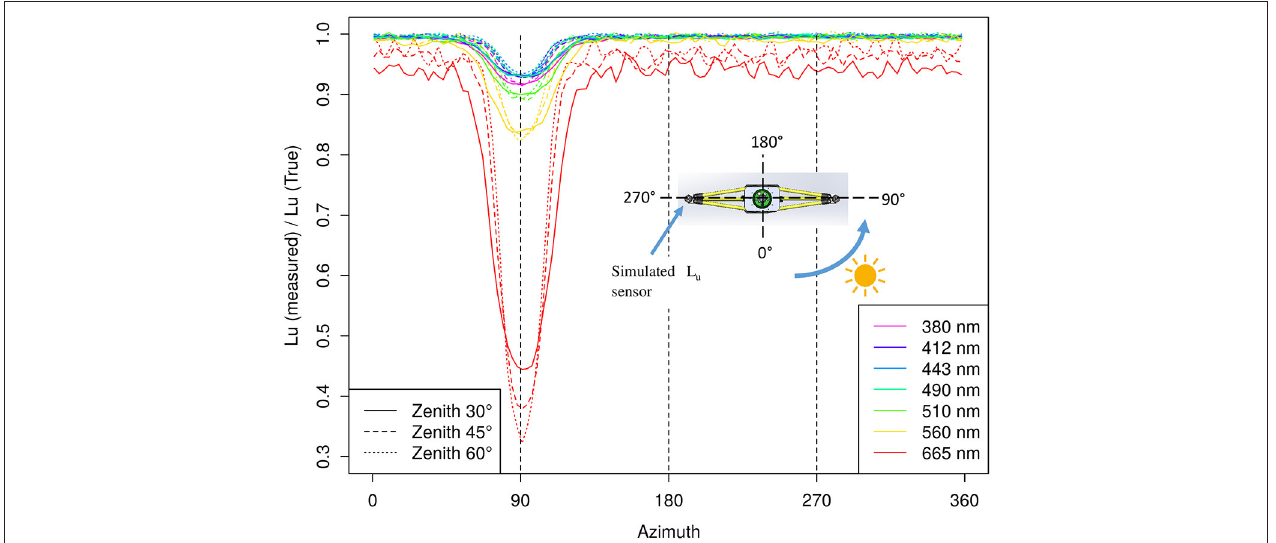
FIGURE 3 | Shading estimated by Monte Carlo simulations expressed as ratio between measured and true L u . Simulation realized at 2m depth with sun zenith angles of 30 ◦ , 45 ◦ , and 60 ◦ in a black sky. IOPs derived from [Chla] = 0.1 µ g/L. Azimuth of 90 ◦ corresponds to the maximum shade of the float over the simulated L u